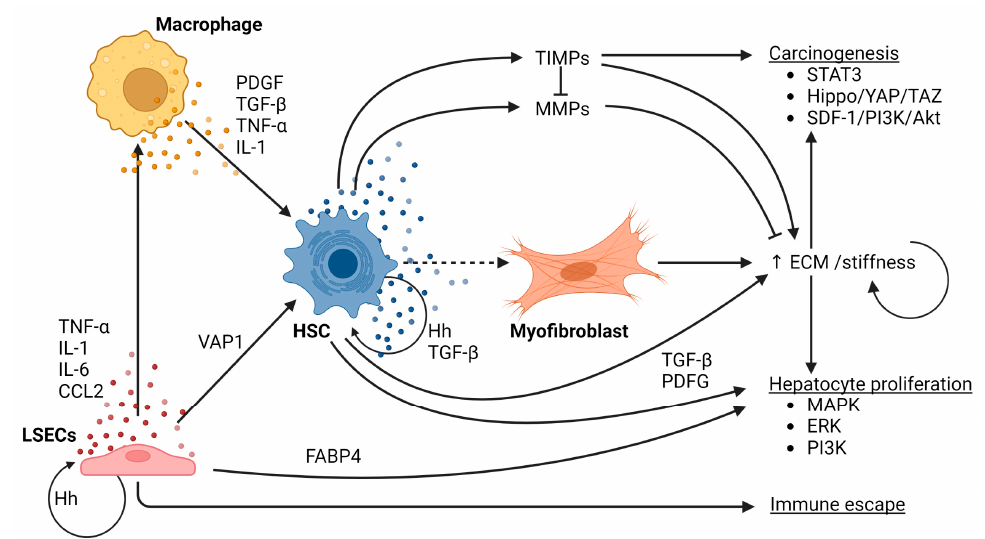
Figure 2. Schematic overview of the role of macrophages, LSECs and HSCs in the process of fibrogenesis and its role in hepatocarcinogenesis in the context of NAFLD.